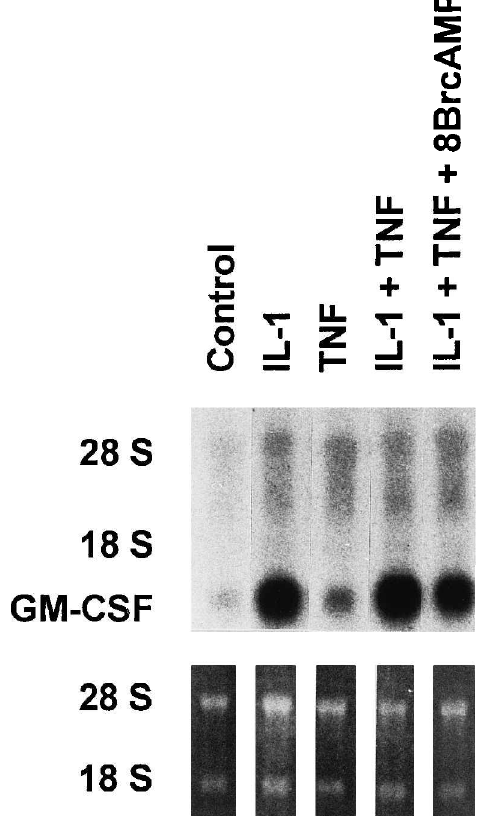
FIG. 1. Induction of GM-CSF mRNA in human bone marrow stromal cells. Confluent secondary stromal cultures were incubated for 6h in medium alone or with the addition of IL-1 (100U/ml), TNF- a (500U/ml), IL-1 plus TNF- a with or without 8BrcAMP (0.5mM). Total cellular RNA was prepared and subjected to Northern-blot analysis with cDNA probe for human GM-CSF. The 18 and 28S rRNA from ethidium bromide stained gel is shown as loading control. Data are representative for two experiments with stromal cells from different